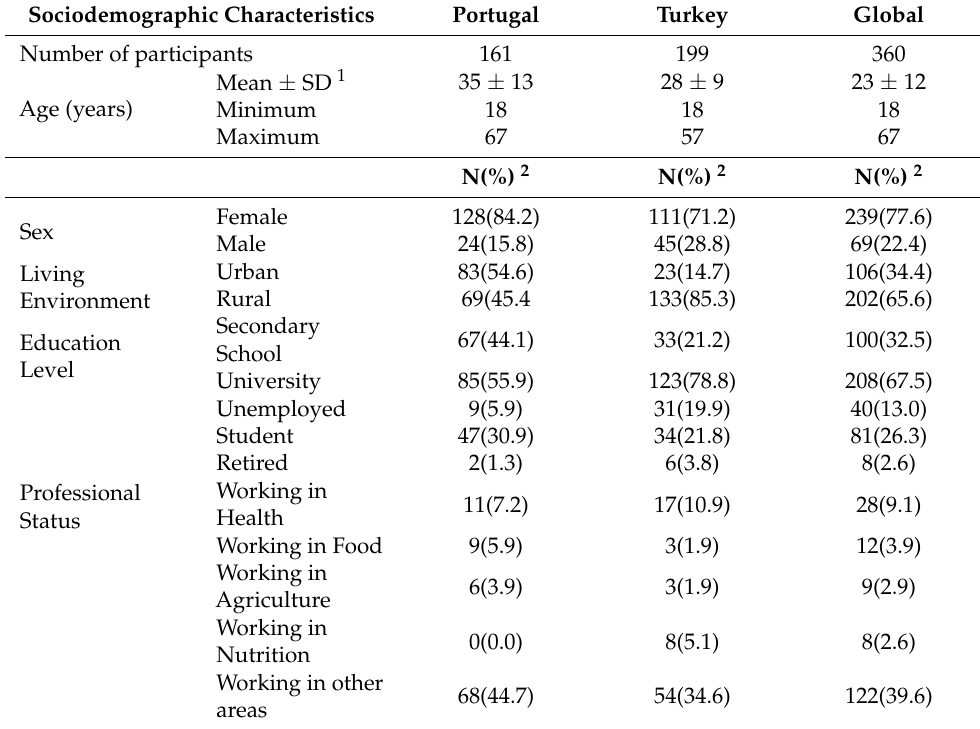
Table 1. Sample characterisation by country and